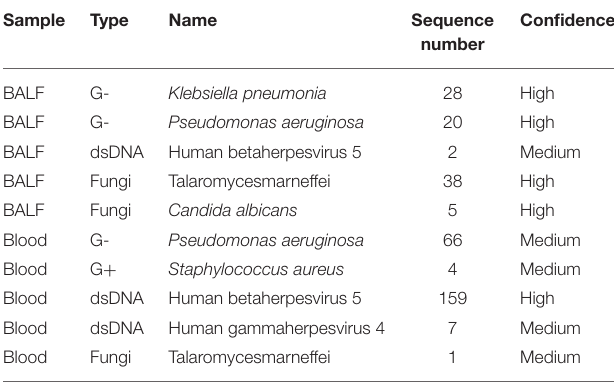
TABLE 4 | Results of mNGS of BALF and